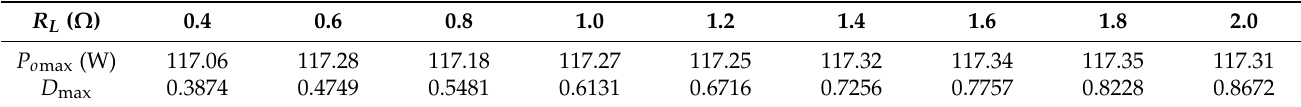
Table 3. MPP values under different load, 800 W/m 2 and 20 ◦ C